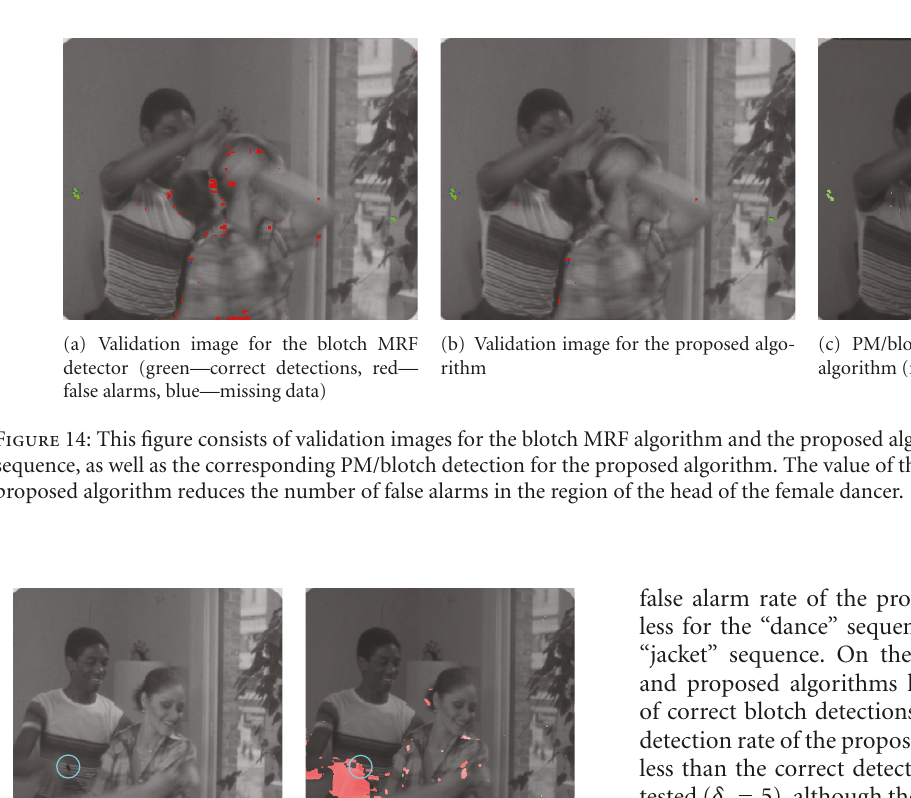
Figure 13: This figure consists of validation images for the blotch MRF algorithm and the proposed algorithm for a frame from the “jacket” sequence. The value of the DFD threshold, δ t , is 15. Also shown is the PM/blotch detection for the proposed algorithm. The blue square highlights the region of the image where the proposed algorithm eliminates false alarms caused by pathological motion. The yellow circles highlight missed blotch detections in the proposed algorithm, which have been wrongly detected as PM.